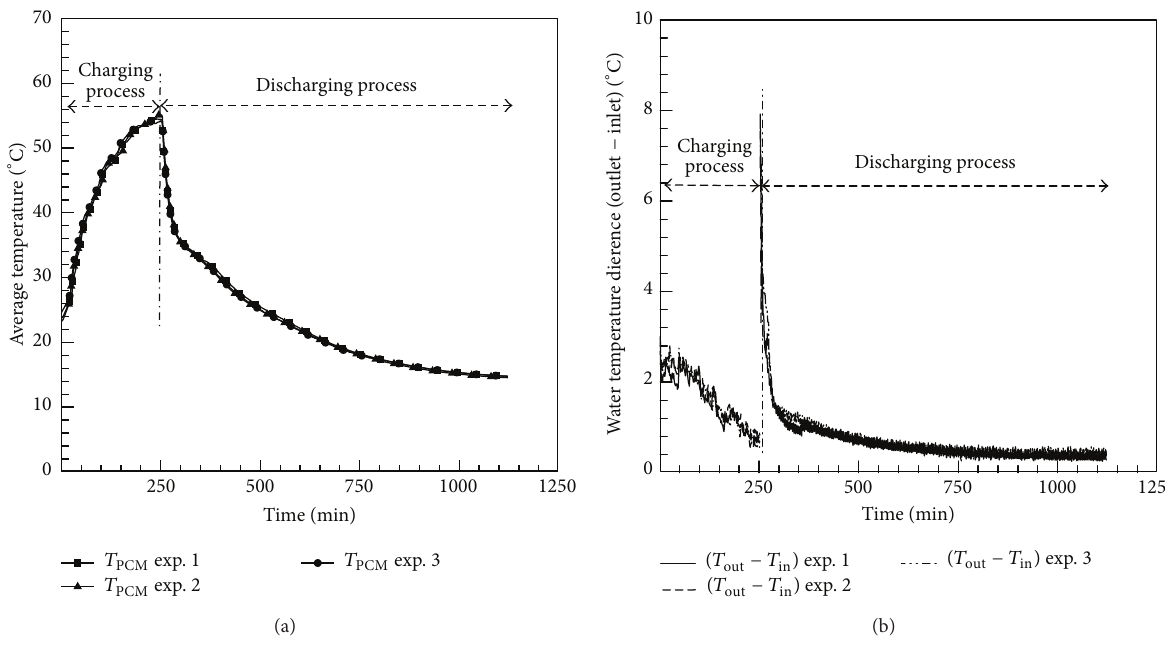
Figure 4: Repeatability of experimental results: (a) the average temperature profile in PCM; (b) water temperature difference (outlet − inlet).